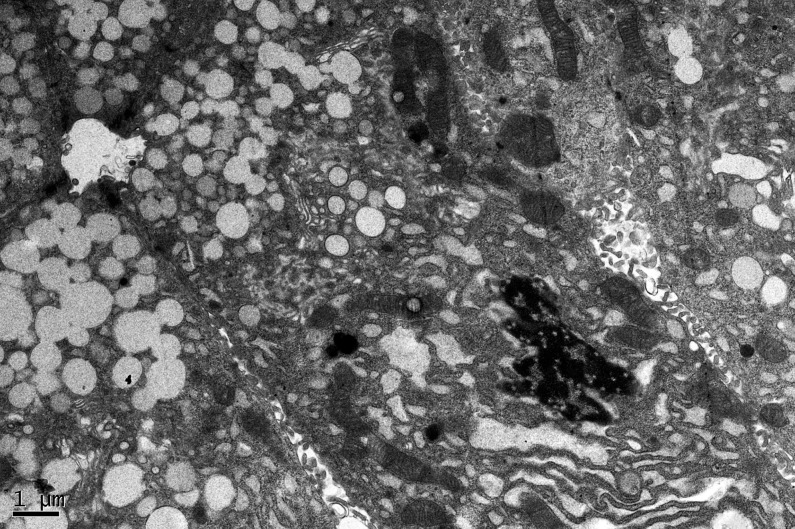
The apoptosis cell of OVX group in lacrimal gland.The apoptosis cells were seen in the OVX group, which had an irregular nuclear with chromatin pyknosis and lost nuclear membrane. Besides, the endoplasmic reticulum was cracked. The scale bar represents 1μm.